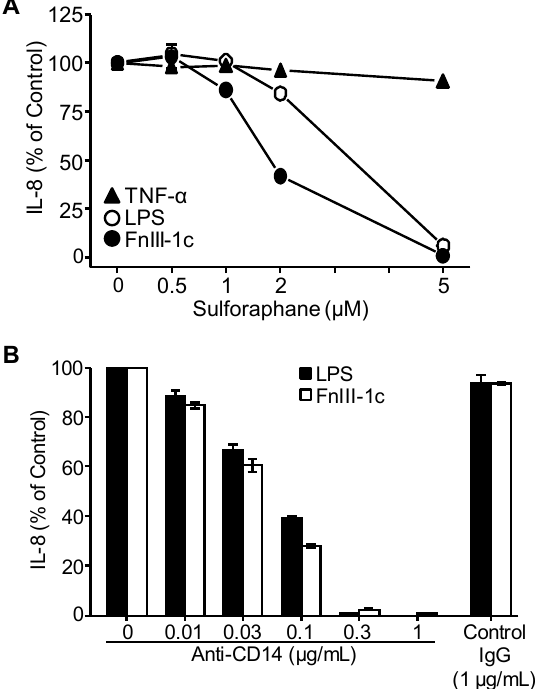
Figure 2. IL-8 induction by LPS and FnIII-1c in dermal fibroblasts requires MD2 and CD14. Monolayers of human dermal fibroblasts were incubated with the ( A ) MD2 inhibitor, sulforaphane, in 10% FBS / DMEM or ( B ) CD14 blocking antibody or control normal IgG in 1% human serum / DMEM. Cells were then treated for 24 hours with either FnIII-1c (10 µM), LPS (100 ng/mL), or TNF- α (25 ng/mL) in the continuing presence of antibodies or inhibitors. IL-8 concentration in conditioned